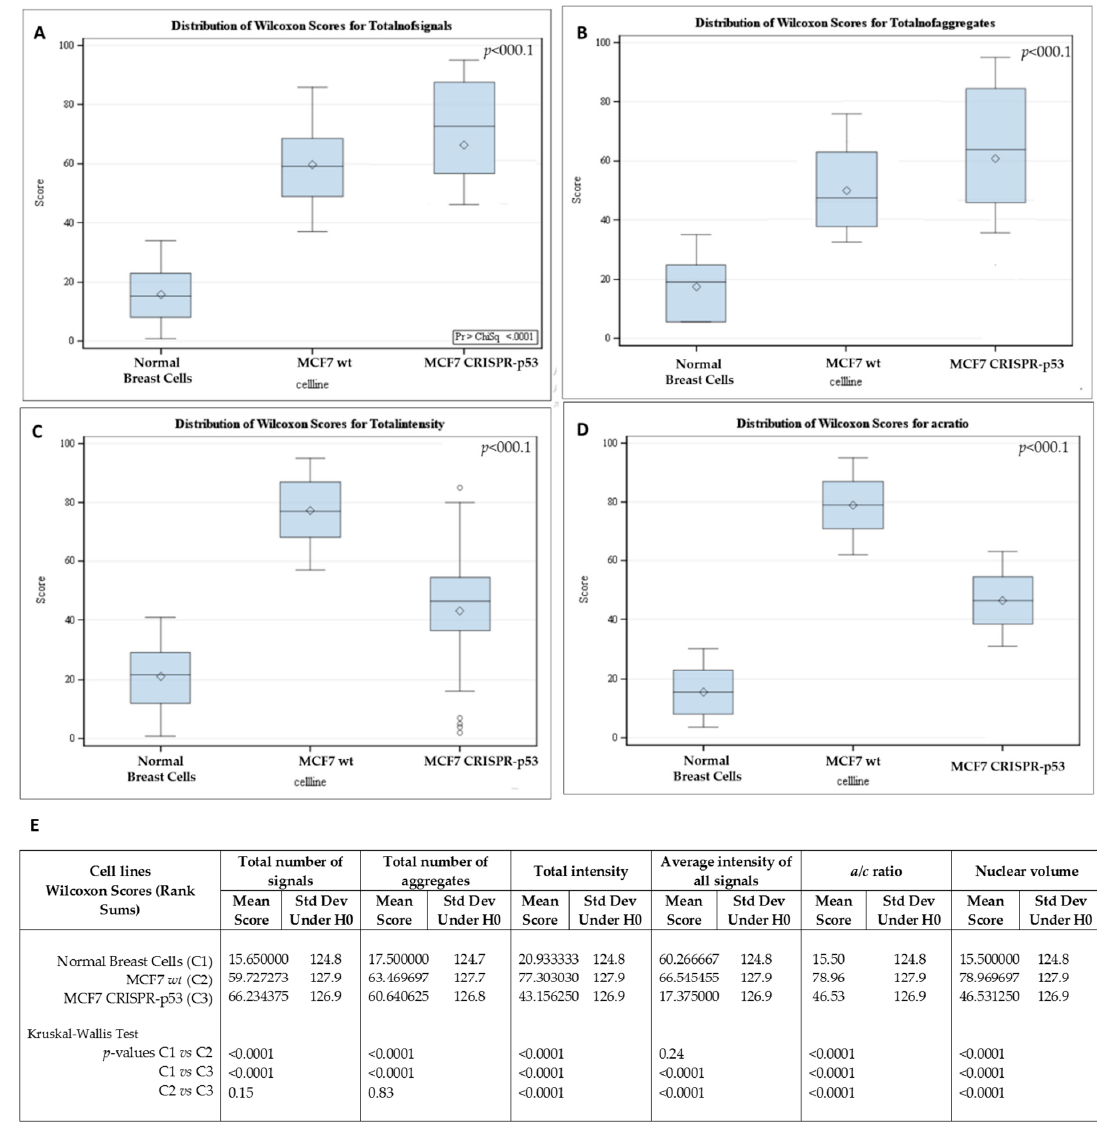
Figure 3. Di ff erences in telomere parameters between normal breast cells, p53 knockout and isogenic wild-type MCF-7 cells. ( A ) The total number of telomere signals. ( B ) The total number of telomere aggregates (telomeres in close proximity that cannot be further resolved at an optical resolution limit of 200 nm). ( C ) Total telomere signal intensity (proportional of telomere length). ( D ) a / c ratio (nuclear spatial distribution of telomeres). The a / c ratio is defined as the nuclear space occupied by telomeres, represented by three axes of length a , b and c . The ratio between the a and c axes, the a / c ratio, reflects the distribution of telomeres, which changes at di ff erent stages of the cell cycle. ( E ) p -values for each comparison. Std Dev—standard deviation; H0—null hypothesis.